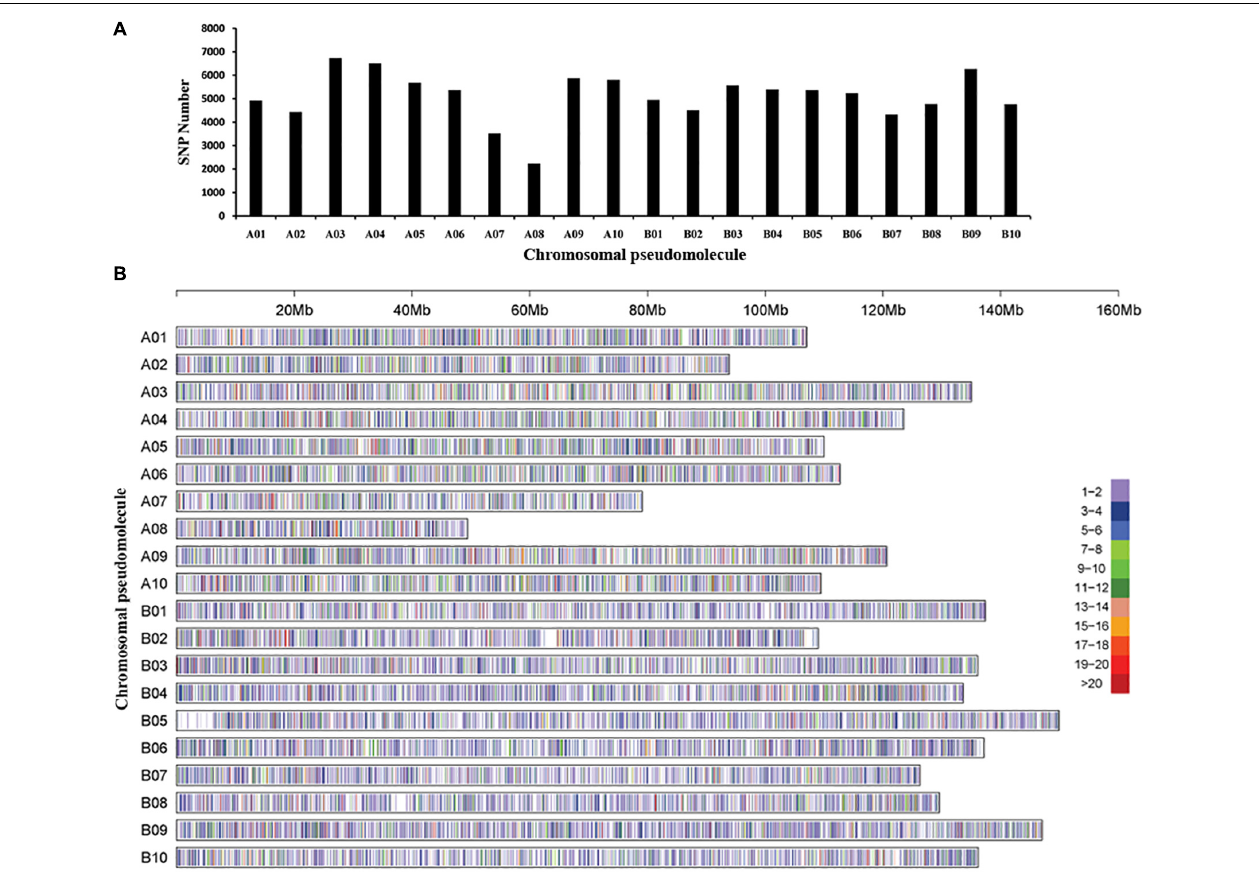
FIGURE 1 | Single-nucleotide polymorphism (SNP) density and distribution across the genome of the peanut. (A) The distribution of the number of SNPs on each chromosomal pseudomolecule. (B) SNP density on each chromosomal pseudomolecule. The horizontal axis shows the length of the pseudomolecule; the number of SNPs per 20-kb window is shown as color